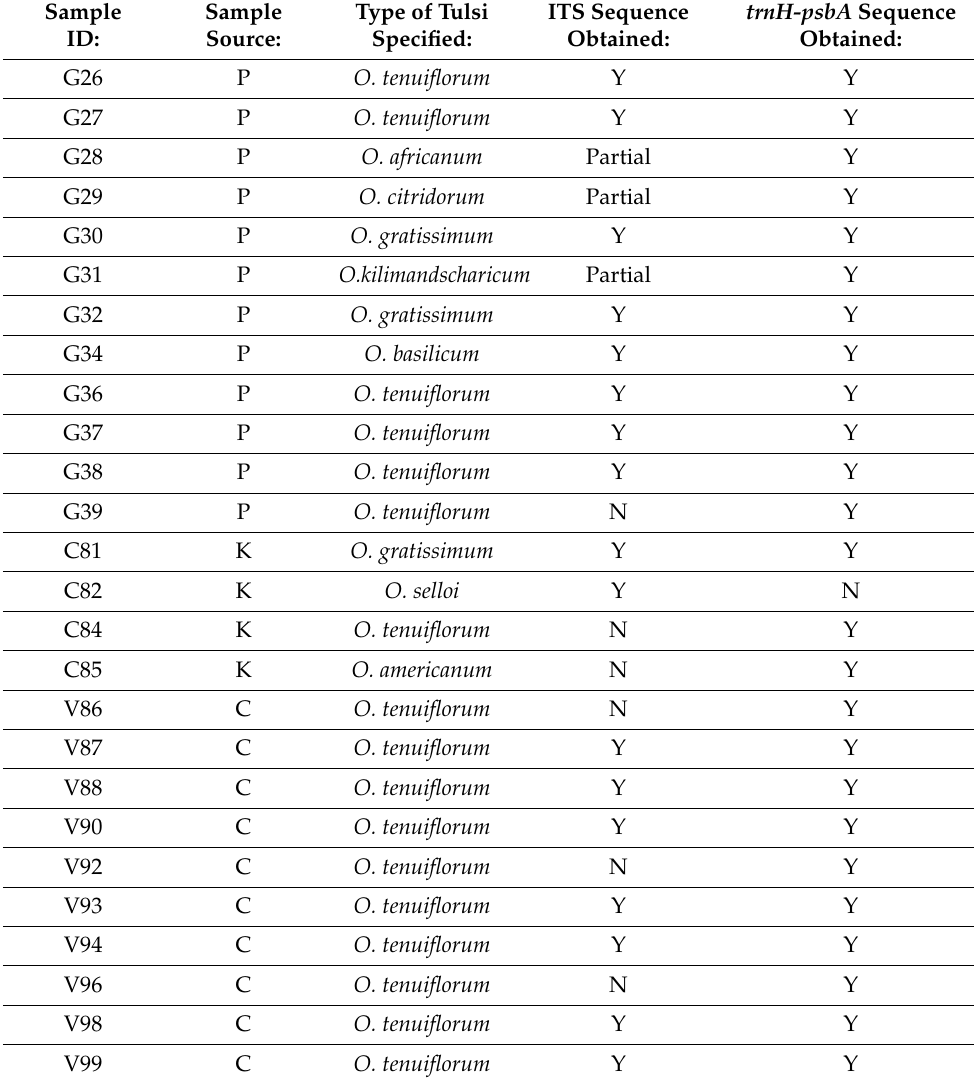
Table 1. Reference Ocimum samples sequenced using ITS and trnH-psbA